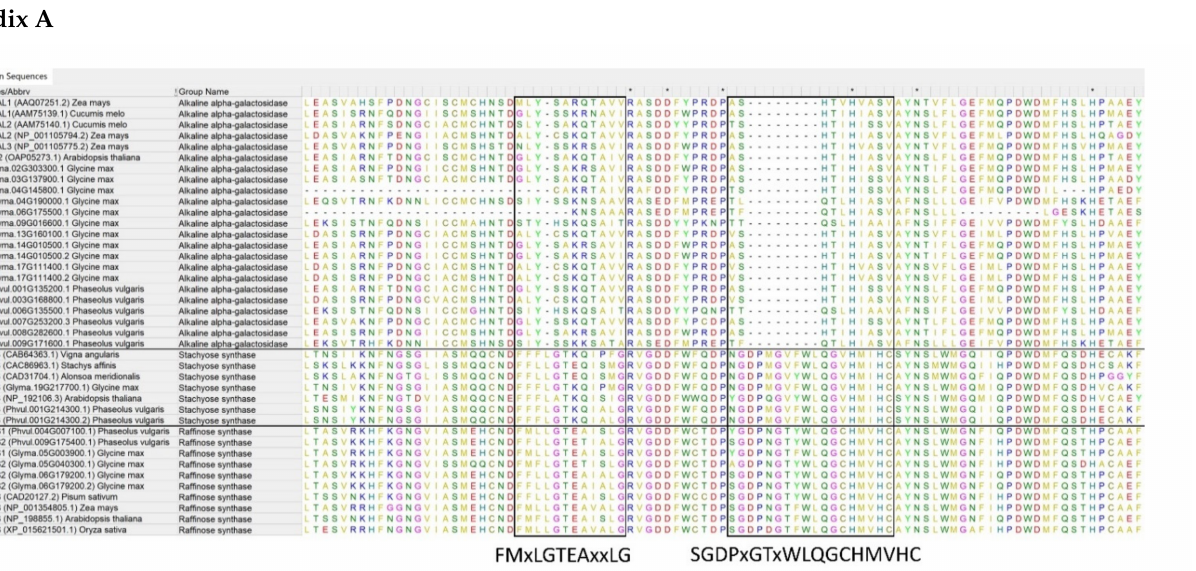
Figure A1. Visualization of the amino acid motifs present in raffinose synthase (RS) but absent in alkaline α -galactosidase. A multiple sequence alignment was performed using the MUSCLE algorithm in MEGA X of the protein sequences of potential RFO synthase enzymes of G. max and P. vulgaris together with well-characterized RFO synthase and alkaline α -galactosidase enzymes of O. sativa , C. melo , Z. mays , A. thaliana , P. sativum , V. angularis , Stachys affinis and Alonsoa meridionalis . To distinguish RS from alkaline α -galactosidase, two conserved motifs, FMxLGTEAxxLG and SGDPxGTxWLQGCHMVHC, were used. These motifs are present in the amino acid sequence of RS but absent in alkaline α -galactosidase